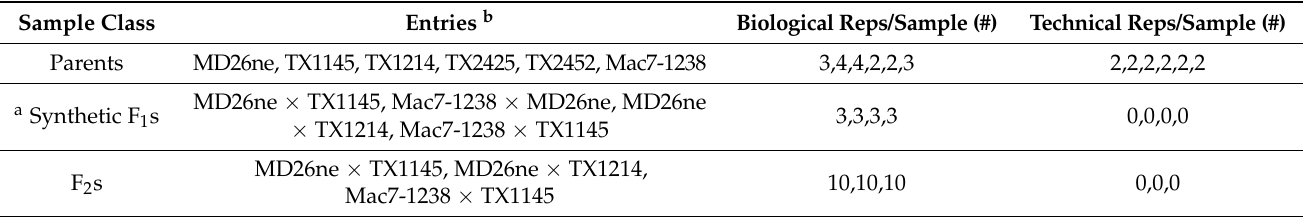
Table 4. Testing panel for validation of KASP markers associated with cotton leaf curl virus (CLCuV) Quantitative Trait